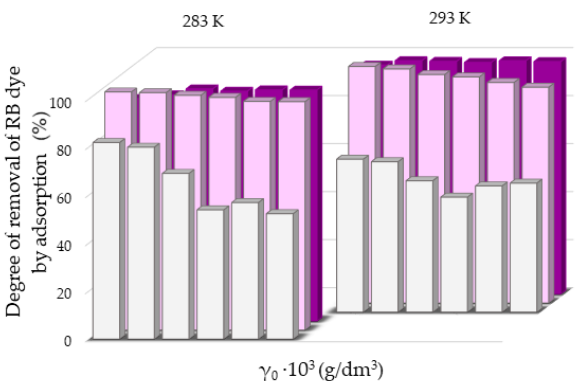
Figure 6. Freundlich adsorption isotherm curves for the suspension MB-NaY at ▲ 283 K and ▲ 293 K.